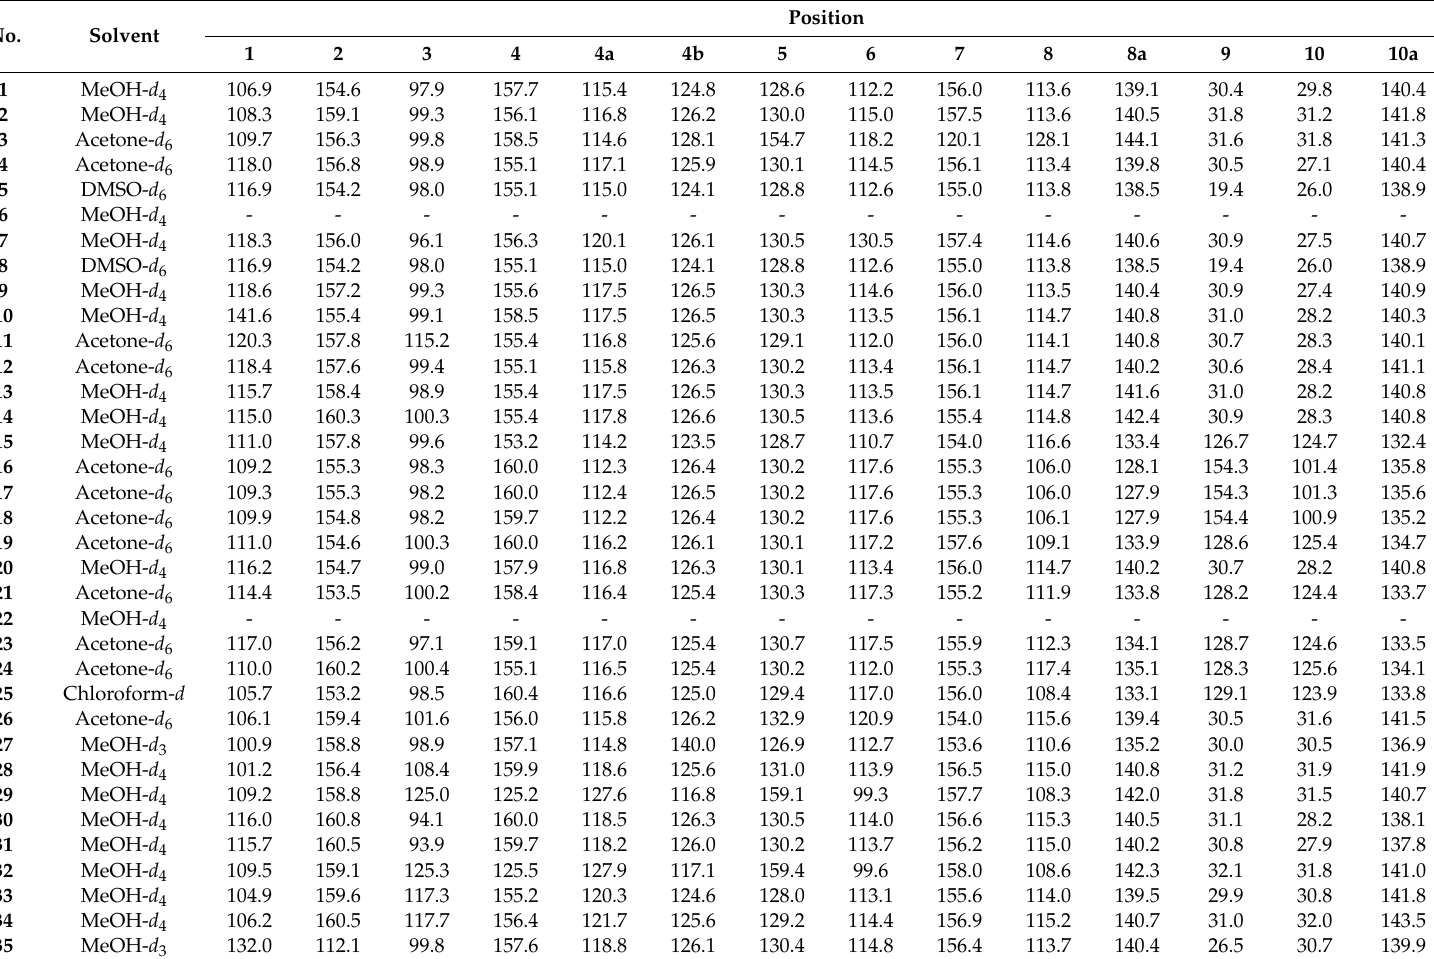
Table 2. 13 C NMR data of compounds 1 – 57